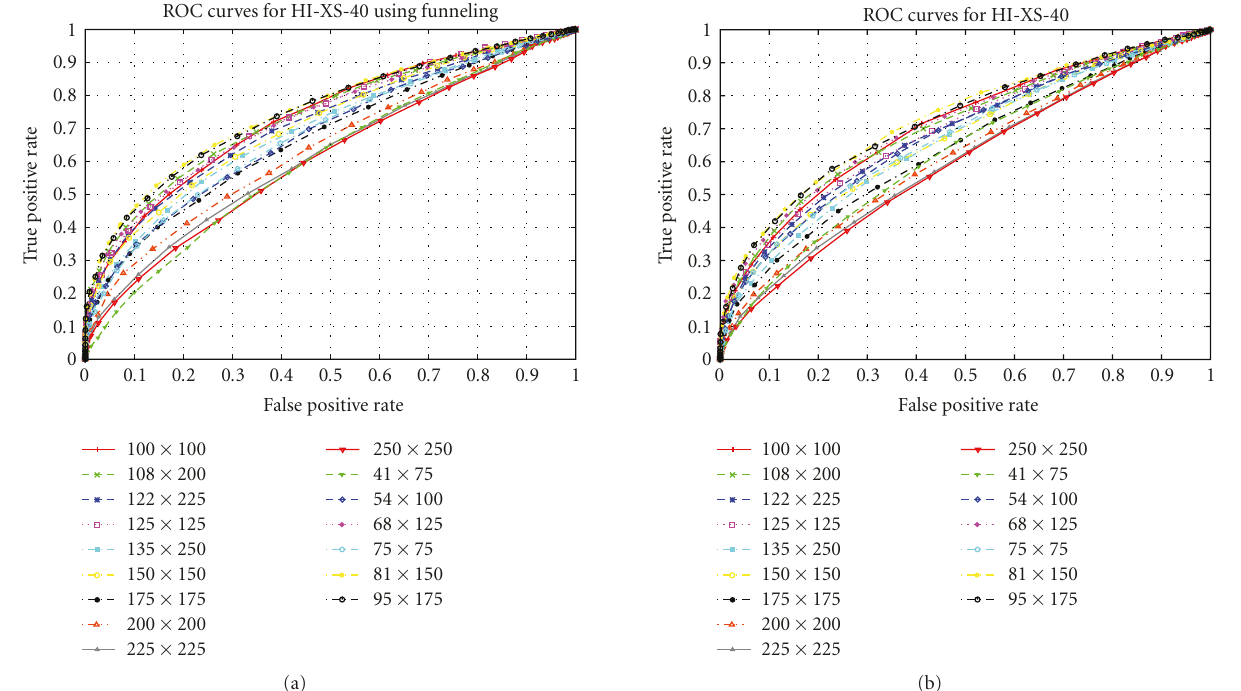
Figure 5: E ff ect of the image’s region size on the performance of the H-XS-40. (a) Faces aligned using funneling; (b) unaligned faces.